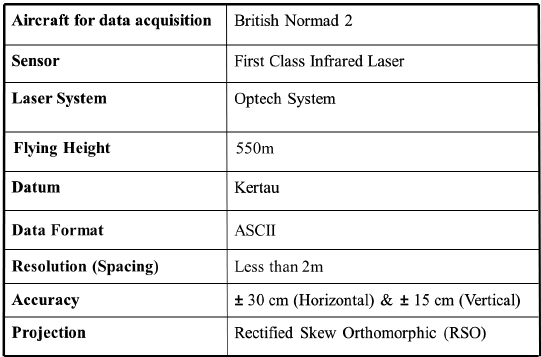
Table 1 . Specifications of the acquired LiDAR datasets